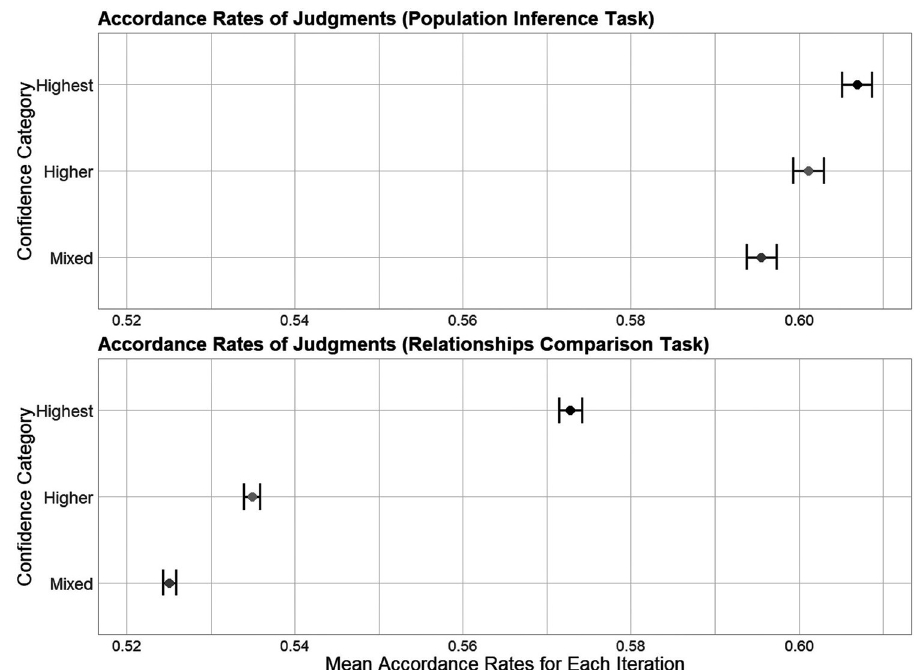
Fig 6. Accordance rates of two individuals’ judgments. We calculated the mean accordance rates (averaged in 105 pairs) in 5,000 iterations of computer simulations. Each point and the error bars denote the mean of accordance rate and 95% confidence intervals,